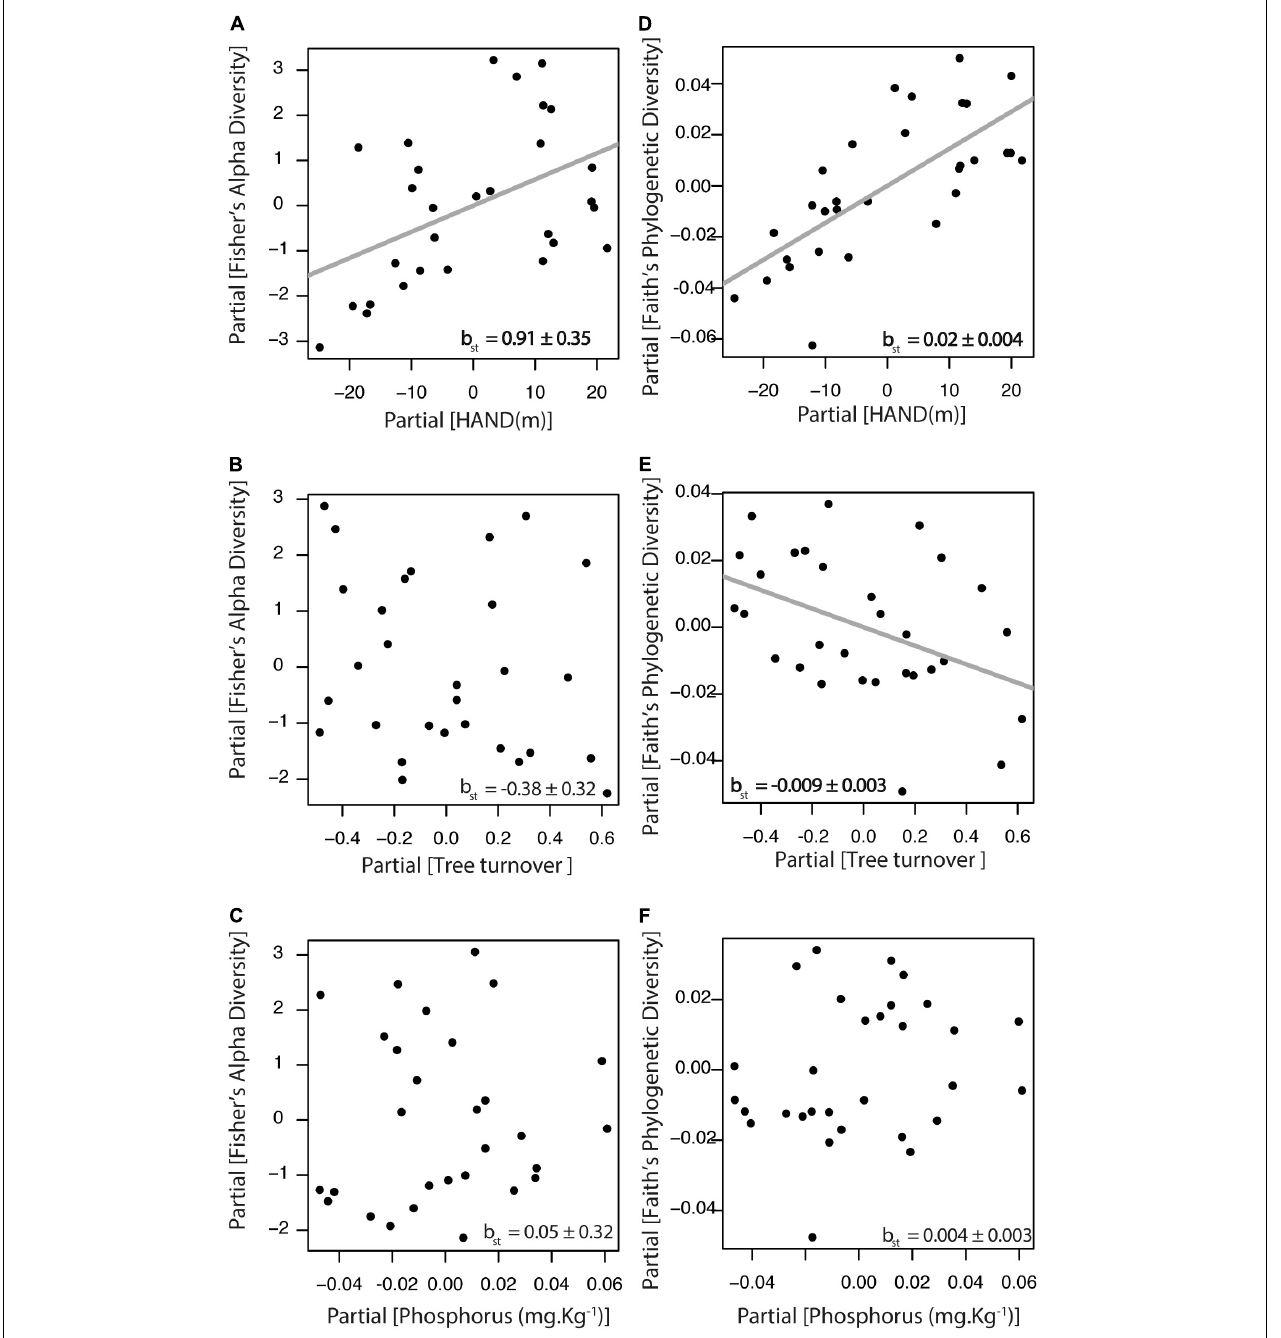
FIGURE 2 | Relationship between liana species diversity and the three environmental gradients at Ducke Reserve (Central Amazon, Brazil). All relationships are partial regressions from models, including HAND (height above the nearest drainage), tree turnover and soil P content as predictive variables. (A–C) Fisher’s alpha diversity index; (D–F) Faith‘s phylogenetic diversity. Gray lines represent significant relationships ( p < 0.05), and standardized multiple linear regression coefficients ( β st ± SE) are shown in the graphs.